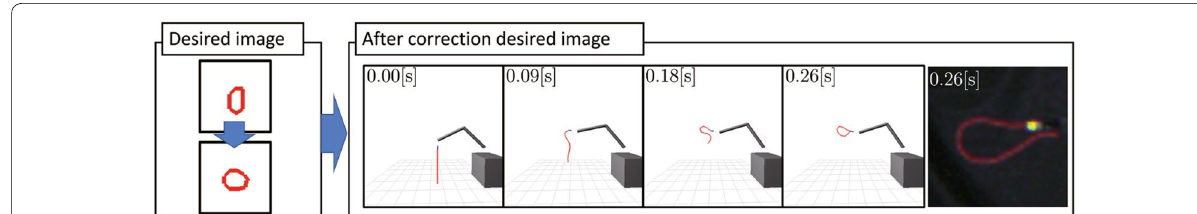
Fig. 16 Effects of correction of desired image of string shape: O